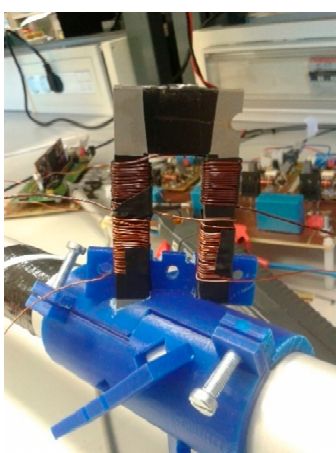
Figure 16. Magnetostrictive transducer based on the use of a magnetic core.